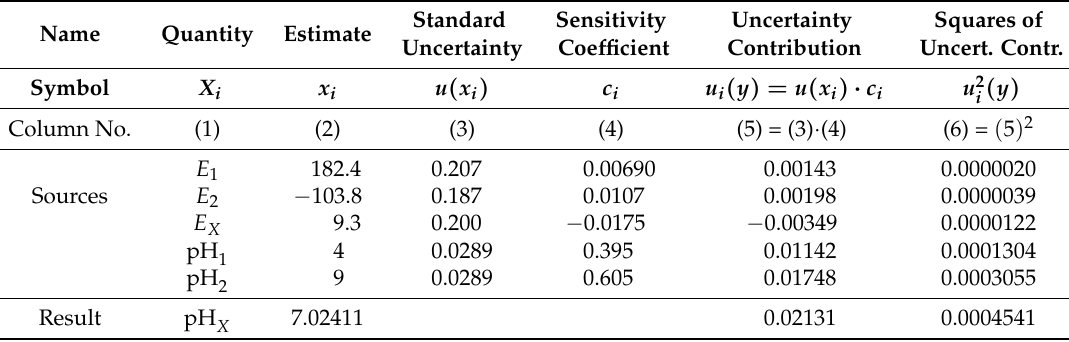
Table 2. Uncertainty budget for the pH